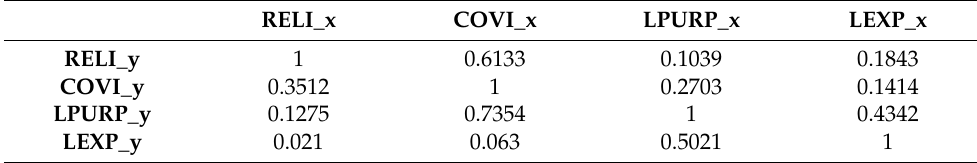
Table 2. Granger causality p -values.